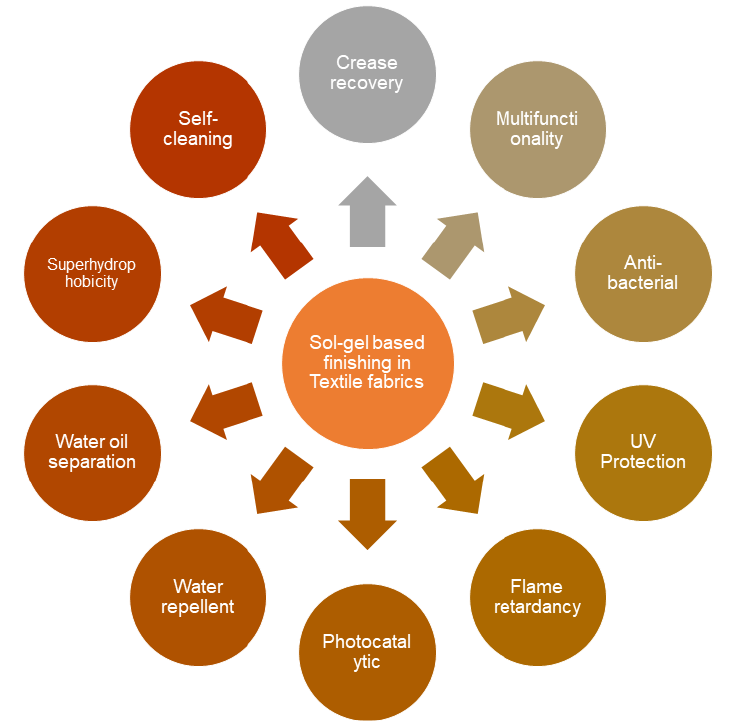
Figure 1. Various applications of sol-gel finishing on textile fabrics.